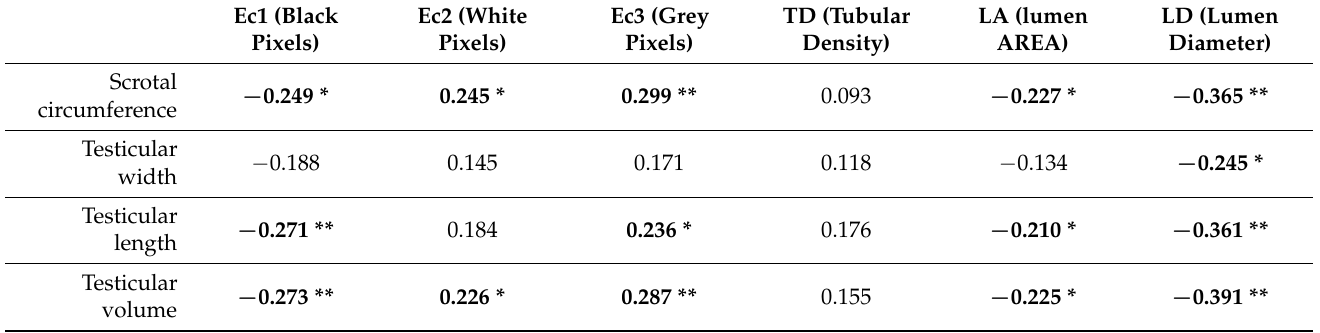
Table 6. Spearman’s rank correlation coefficient (Spearman’s ρ ) between testicular size and echotex- ture parameters (evaluated by ultrasound-video analysis and ECOTEXT ® software) in Rasa